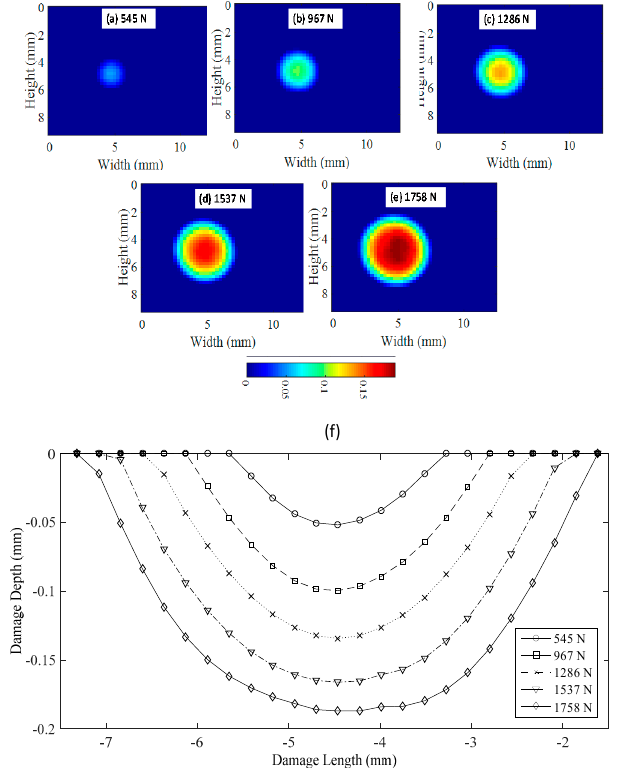
Figure 15. Damage geometry in the contact region during the unloading path for 3 mm thick specimen. ( a – e ) Geometry of the contact damage region for different displacement steps (20%, 40%, 60%, 80% and 100% cylinder displacement with a maximum of − 2 mm) during the loading path for 3 mm thick specimen; ( f ) Profiles of the contact damage depth for the different displacements steps.